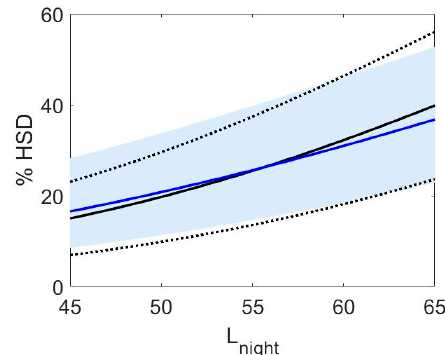
Figure 9. The percent highly sleep disturbed (HSD) based on responses to questions on awakenings, difficulty falling asleep, and sleep disturbance for aircraft noise (black dashed lines: 95% confidence intervals). The number of studies and subjects contributing to the analyses can be found in Table 2. Blue: Janssen and Vos (2009) [87] highly sleep disturbed exposure-response curve.